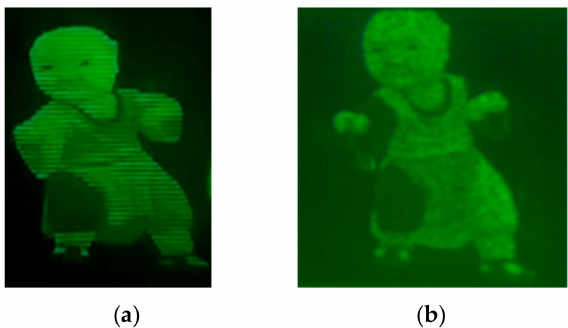
Figure 7. Optical reconstructions. ( a ) Proposed method; ( b ) 3D cloud point data method.